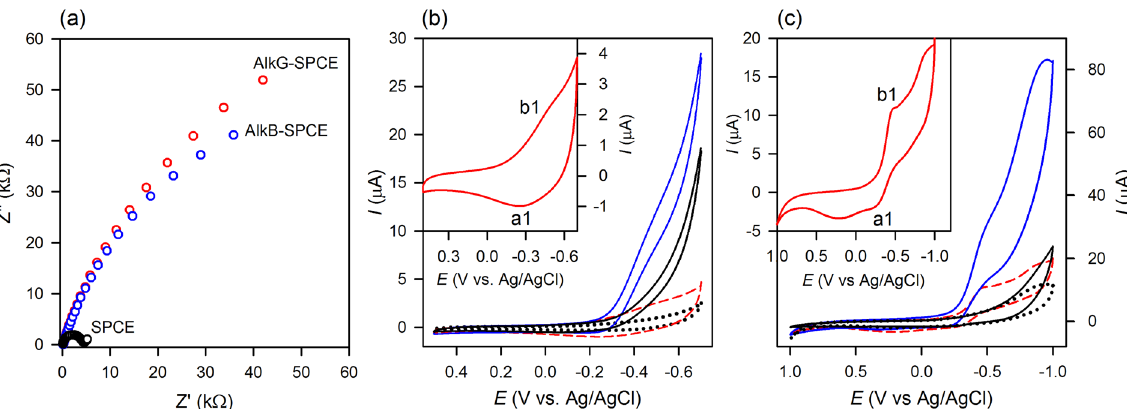
observed from AlkB-enriched membrane using a SPCE without AlkG (Figure S6 in Supplementary Information). It is found that the highest specific activity can be achieved if operated within 30-min duration. The obtained specific activity in turnover frequency (TOF) per AlkB–AlkG complex (min − 1 ∙protein − 1 ) is related to the actual concentration of AlkB bound with the immobilized AlkG on the SPCE. A one-site binding model can fairly describe the change in the specific activity with the concentration of AlkB bound to AlkG, yielding the coefficient of determination (R 2 ) of 0.984, the maximum activity of 1,100 min − 1 ∙protein − 1 as well as K d of 268 μ M (data not shown). However, if a two-site binding model is employed (Fig. 5), the change in the specific activity with the con- centration of AlkB bound to AlkG of 322 and 776 min − 1 ∙protein − 1 can be obtained. Both dissociation constants, K d , from AlkB-enriched membrane are determined to be 268 μ M. Alkane hydroxylation via electrocatalysis. The effective surface coverage ratio of AlkG for DET from a SPCE to AlkG is within 0.5–2% 48 . Data obtained from catalytic conversion mediated by SPCE electrodes show that the apparent TOFs (based on the amount of AlkG placed on top of SPCE instead of electroactive AlkG, i.e. the effective surface coverage ratio of AlkG) of C 5 –C 12 range within 250–1000 min − 1 per unit AlkG, where the concentration ratio of AlkB to AlkG is about 2 (Fig. 6; confer Figures S6 and S7 in Supplementary Information for GC chromatograms). The specific activities (in TOF) for the conversion of C 6 , C 7 and C 9 n -alkanes to pri- mary alcohols are in the range of 500–1,000 min − 1 (Fig. 7). The TOFs for the conversion of C 5 , C 8 and C 10 − C 12 n -alkanes to corresponding primary alcohols are within 250–400 min − 1 . Herein, unprecedented results for the conversion of gaseous propane (C 3 ) and n -butane (C 4 ) to 1-propanol and 1-butanol, respectively, are noted; TOFs for the gas-to-liquid (GTL) conversion are 16 ± 2 and 106 ± 6 min − 1 , respectively.